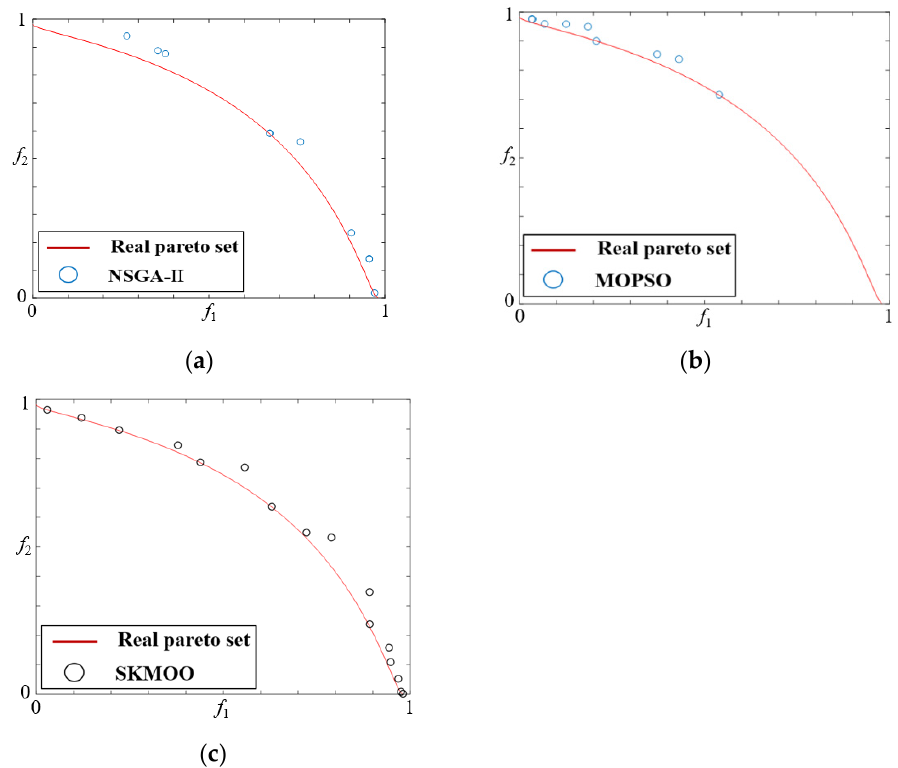
Figure 7. Pareto front set of test function3 ( a ) NSGA-II; ( b ) MOPSO; ( c ) SKMOO.